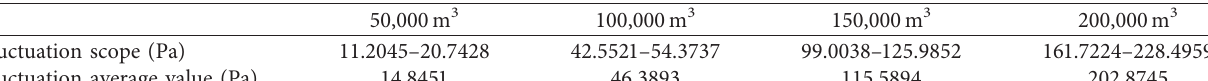
Table 6: Dynamic pressure fluctuation scope at 80 ° flap angle.